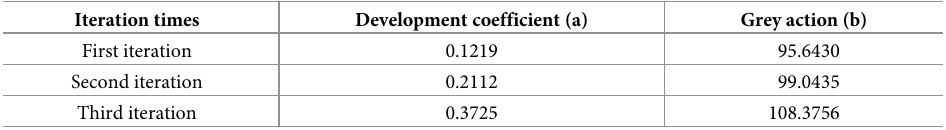
Table 4. Results of metabolic GM (1,1)